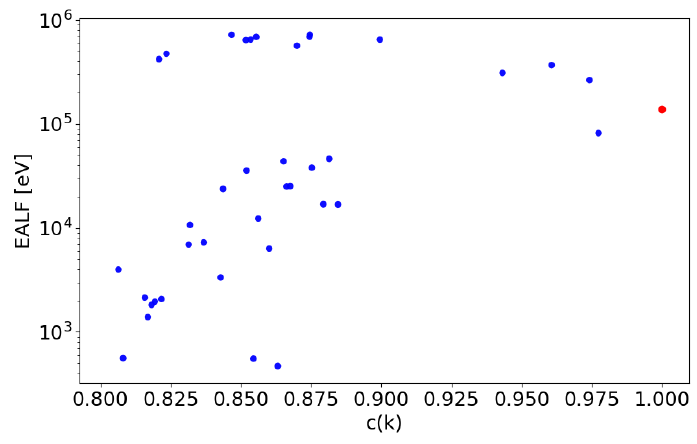
Figure 3d. Updated EALF for the relevant experiments and Case 3.